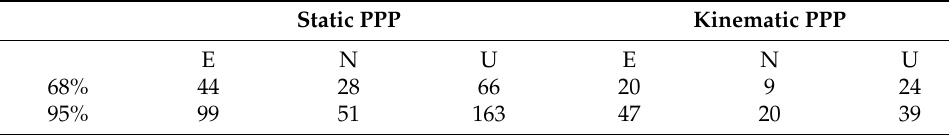
Table 5. Convergence time of the EG method (unit: min) (G/R). Static PPP